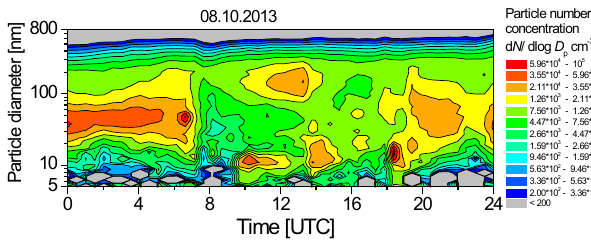
Figure 12. Aerosol number concentration measured with a TSMPS in Melpitz on 8 October